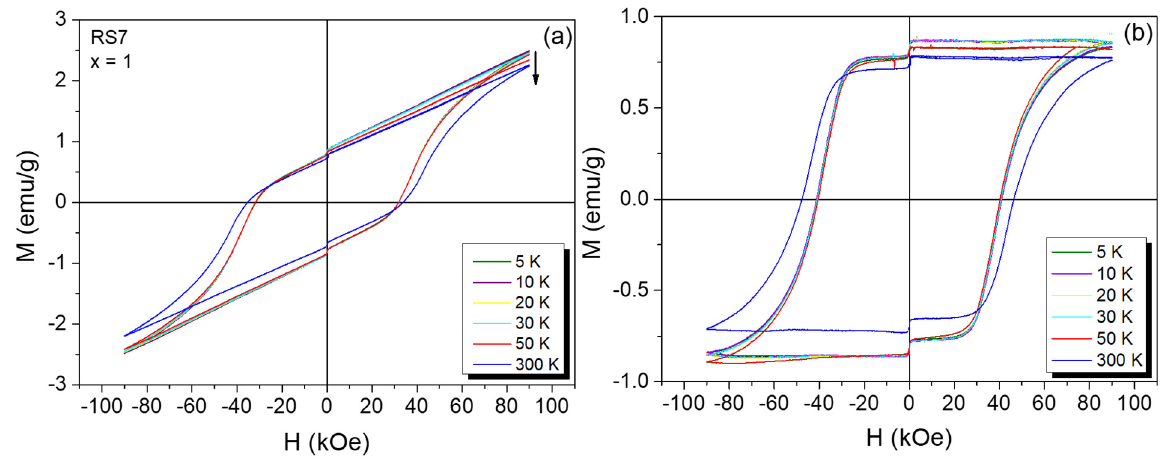
Figure 5. M(H) loops for the RS7 sample recorded at different temperatures ( a ). M(H) loops after the subtraction of the paramagnetic contribution of the AFM phase ( b ).